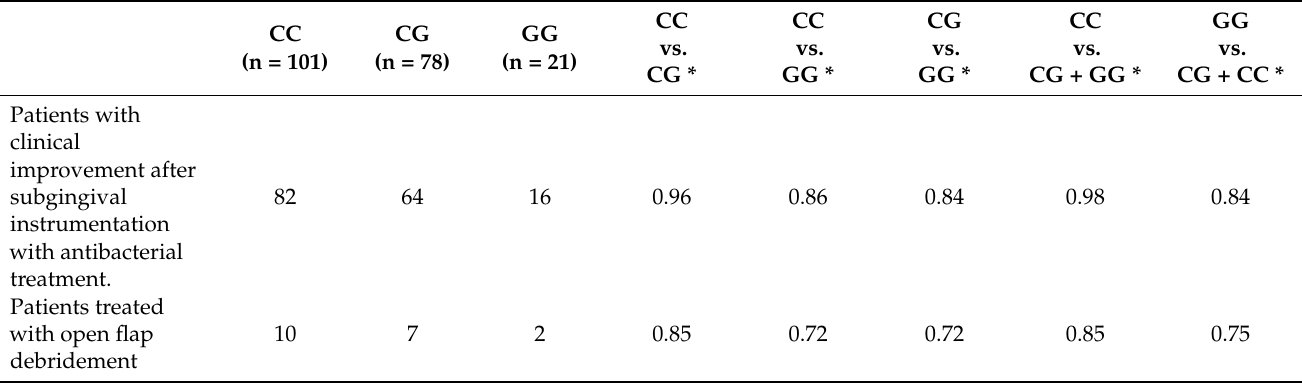
Table 7. The associations between the results of therapy and IL-18 rs187238 genotypes.